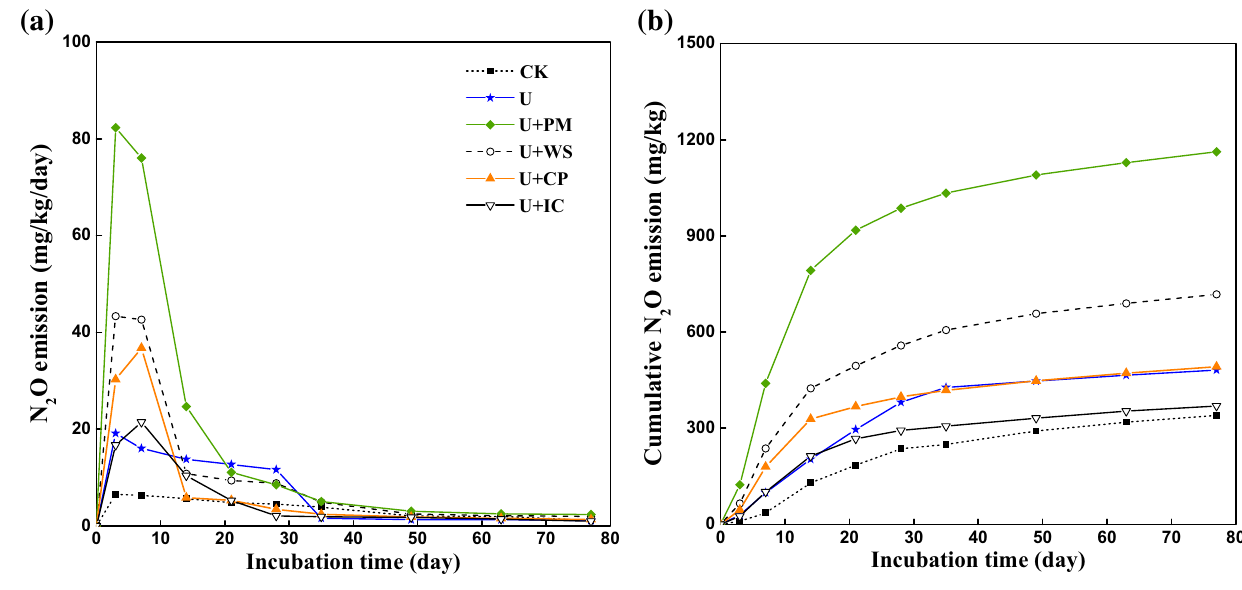
Figure 1. The changes of N 2 O emission ( a ) and cumulative N 2 O emission ( b ) during the incubation affected by different OAs. CK no chemical fertilizer, U urea, U + WS urea plus wheat straw, U + PM urea plus pig manure, U + CP urea plus compost, U + IC urea plus improved